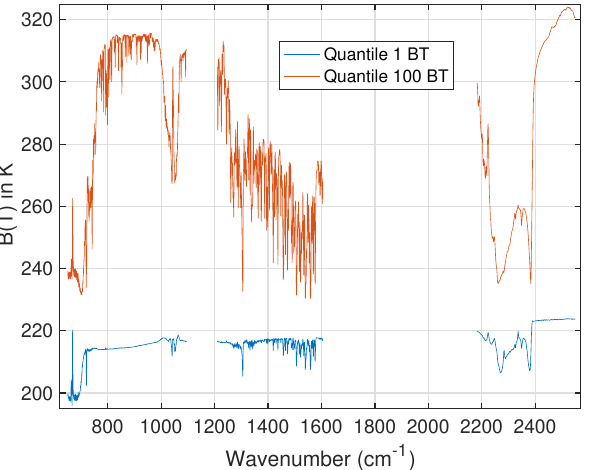
Figure 11. BT values for maximum (quantile 0.99–1.00) and minimum (quantile 0.00–0.01) returned by a 100-bin cumulative probability calculation on the 1% equal-area sampling of CHIRP-AQ and CHIRP-SN radiances for 2018. Quantiles had constant cumulative probability steps of 0.01 (1% probability).